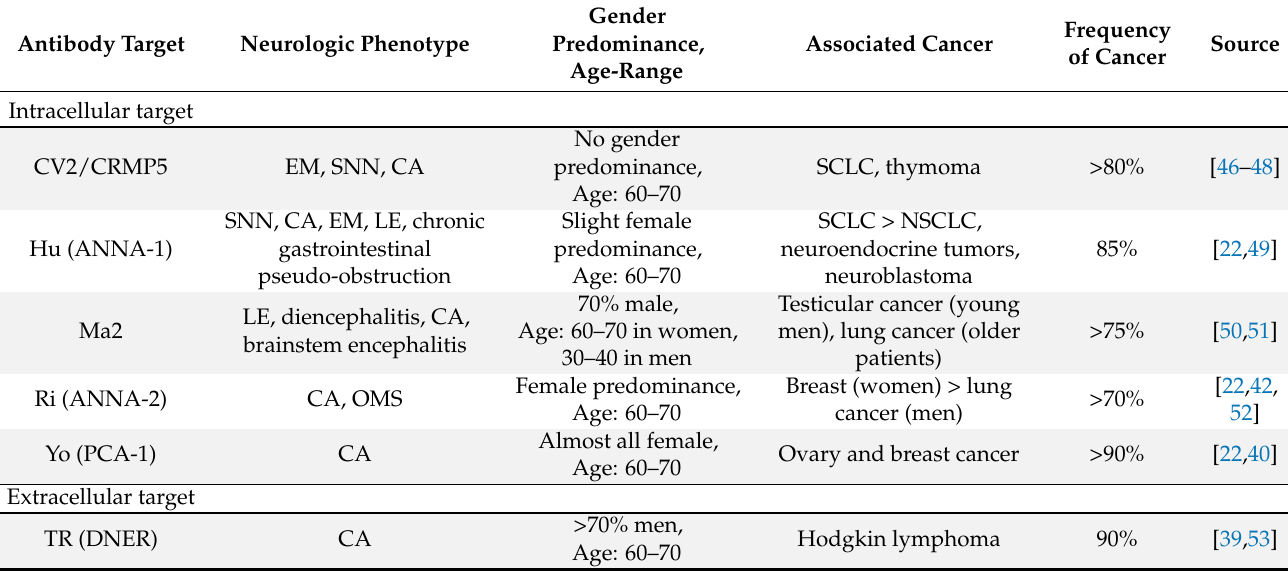
Table adopted from Mitoma et al. and Graus et al. [1,6]. Abbreviations: CV2/CRMP5 : collapsin response-mediator protein 5, Hu (ANNA-1) : antineuronal nuclear antibody-1; Ma2 : metabotropic glutamate receptor2; Ri (ANNA-2) : antineuronal nuclear antibody-2; Yo (PCA-1) : Purkinje cell antibody; TR (DNER) : delta/notch-like epidermal growth factor–related receptor; CA: cerebellar ataxia; EM: encephalomyelitis; LE: limbic encephalitis; NSCLC: non-small-cell lung cancer; OMS: opsoclonus myoclonus syndrome; SCLC: small-cell lung cancer; SSN: subacute sensory